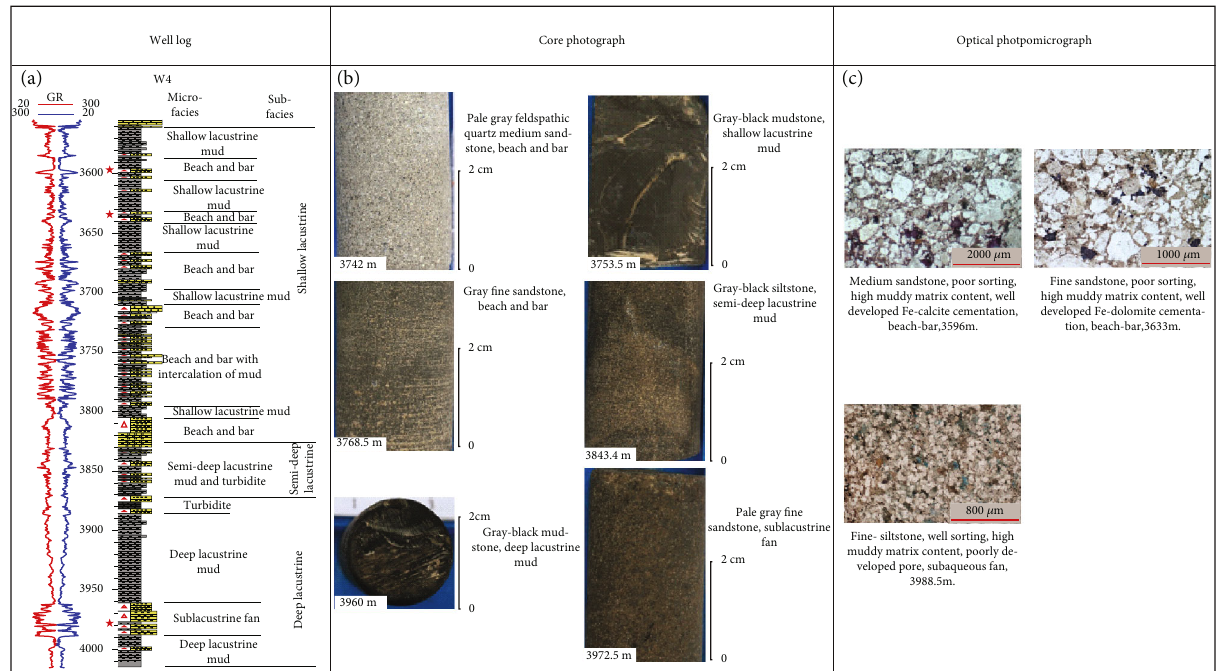
Figure 5: Typical logging curves (a), core photos (b), and optical photomicrograph (c) show the Lacustrine characteristics, especially the beach-bar and subaqueous fan. The well location is marked in Figure